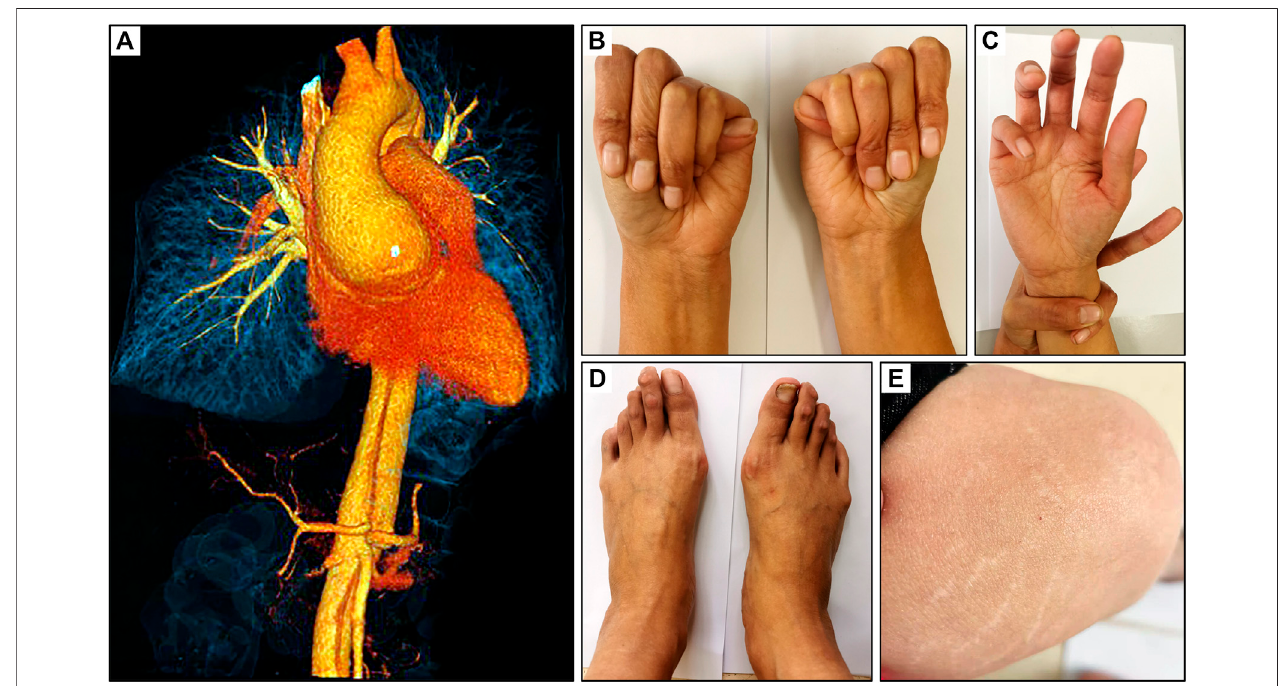
FIGURE1| Clinicalpresentationofa32-year-oldfemalewithMFS. (A) CTscanrevealedanaorticrootdilatationandDebakeyIdissection, (B) positivethumbsign, (C) positive wrist sign, (D) plain pes planus and (E) skin striae.